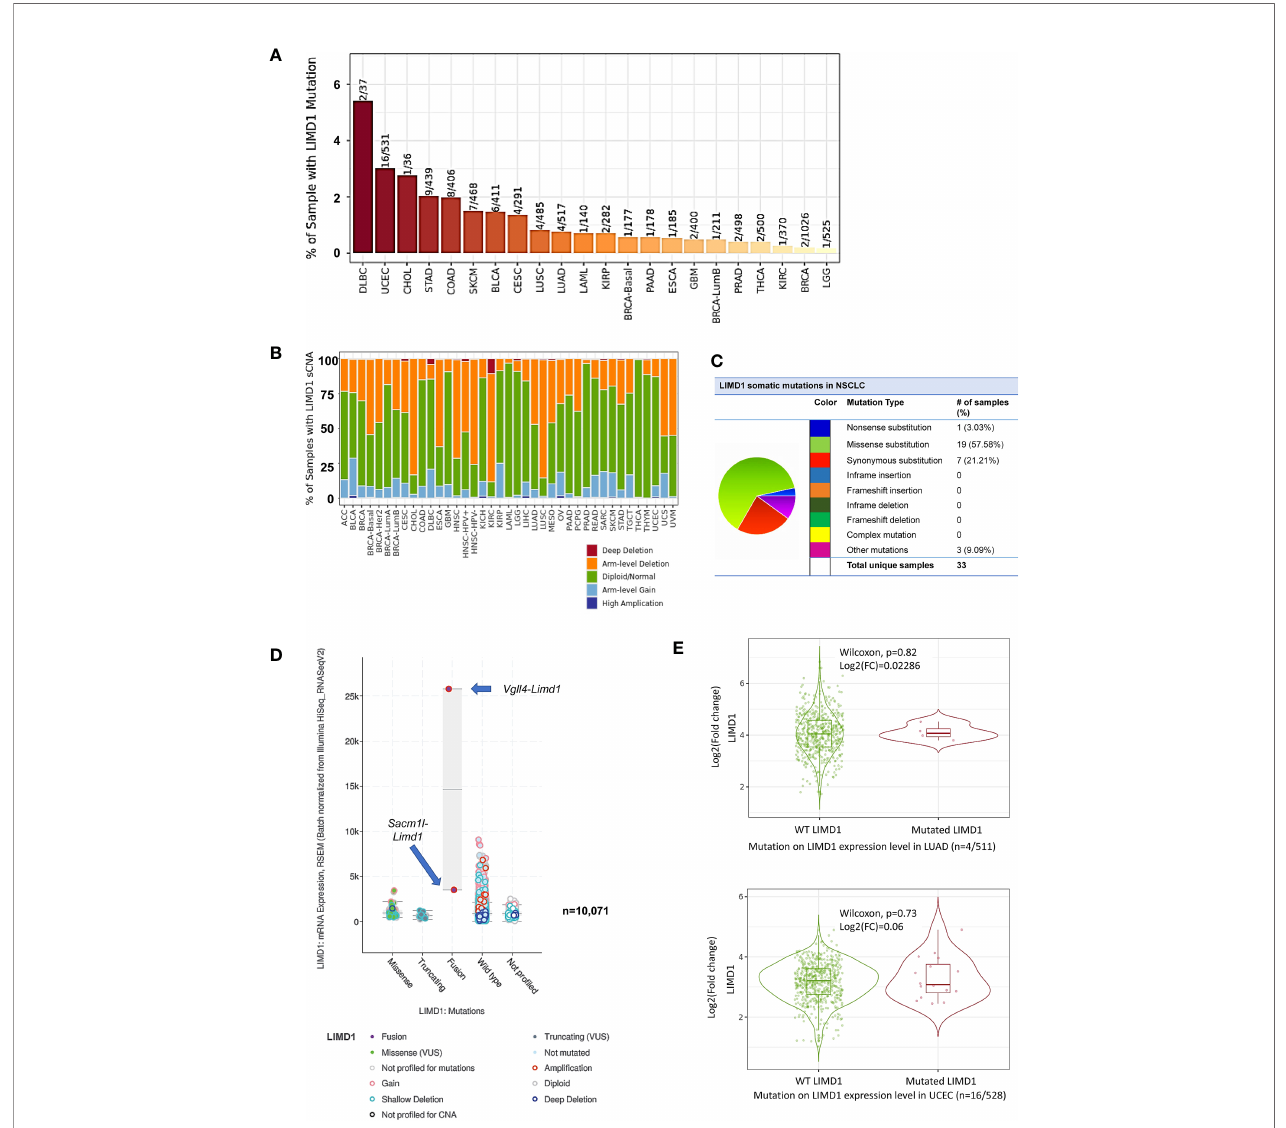
FIGURE 3 | Pro fi le of Limd1 gene mutation in cancers. (A) Frequencies of Limd1 gene mutation in various cancers. (B) Frequencies of Limd1 somatic copy number alteration (sCNA). (C) Frequencies of Limd1 somatic mutations (substitutions, deletions, and insertions) in NSCLC. (D) Effects of LIMD1 mutation on its expression in various cancers. (E) Representative results from LUAD and UCEC show that LIMD1 mutation has no signi fi cant effects on its expression. (A, B, E) are the results from TIMER2, (C) from COSMIC, and (D) from cBioportal. FC, Fold